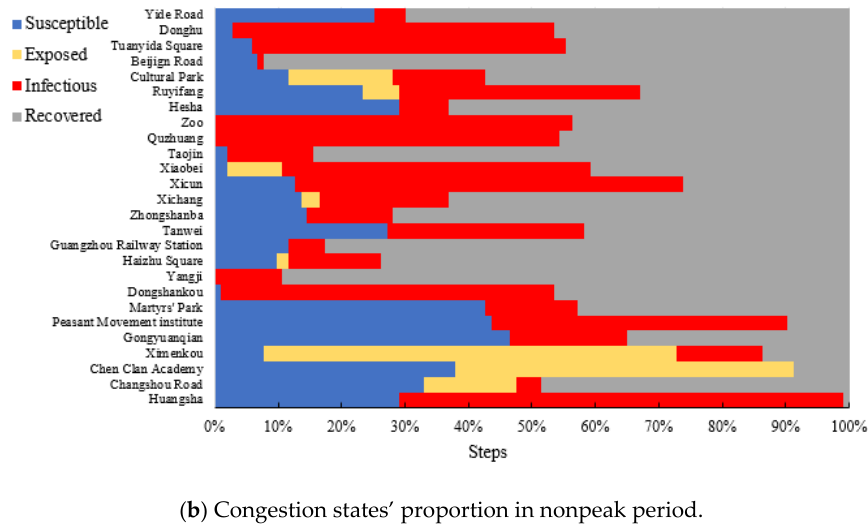
Figure 12. Congestion states in the GZM network.